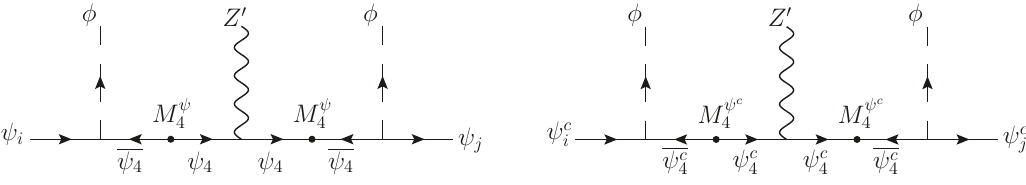
Figure 6 . Allowed region of the free parameters of the general scenario when the present bounds [50] on the non-unitarity of the leptonic mixing matrix are considered. The green (purple) area corre- sponds to y (cid:23) ( y (cid:23) ), while the solid (dashed) line is the boundary for NH (IH). 14 j 24 j j j